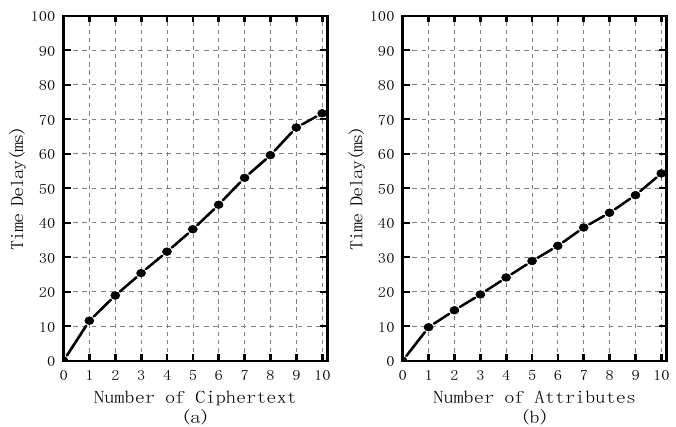
Figure 7. ( a ) Cost of user decryption ( b ) Cost of RSU decryption [23–25].